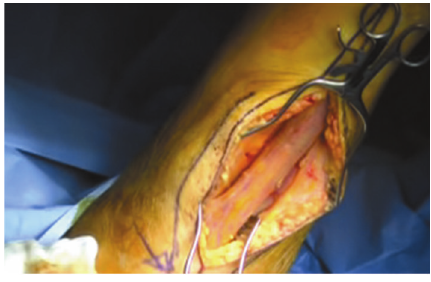
Figure 6: Gracilis muscle.